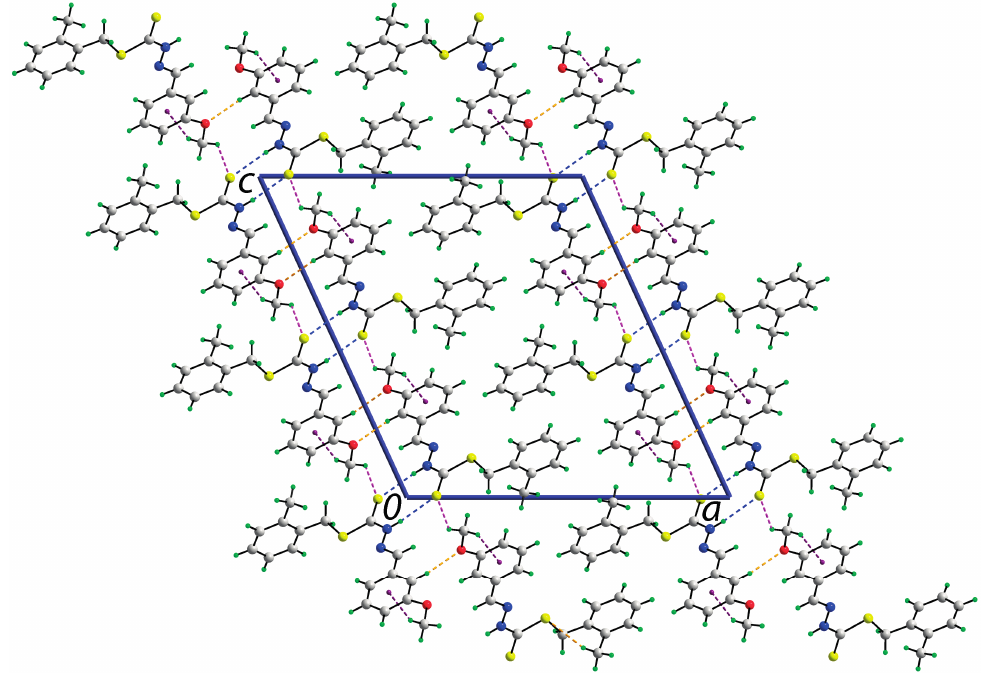
Figure 5. A view in projection down the b -axis of the unit cell contents of 2 . The N ‒ H···S and C ‒ H··· π interactions are indicated by blue and purple dashed lines,